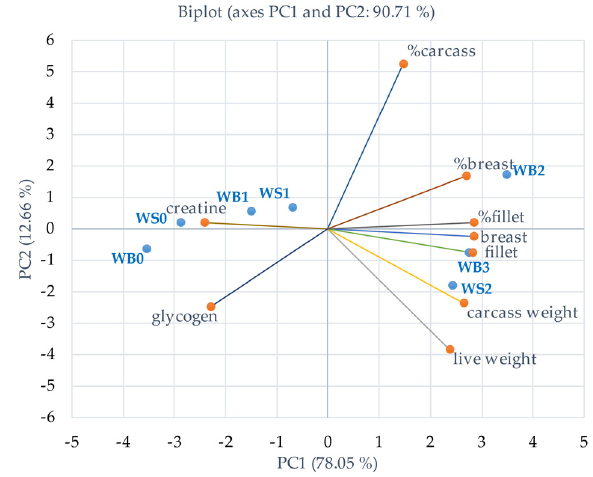
Figure 4. Principal component analysis biplot of wooden breast (WB) and white stripping (WS) severity score and carcass composition of broiler chickens at 42 days of age. WB; 0, 1, 2, 3 = wooden breast scores are based on a 4-point scale (3 = severe, 2 = moderate, 1 = mild, and 0 = normal); WS; 0, 1, 2, 3 = white striping scores are based on a 4-point scale (3 = severe, 2 = moderate, 1 = mild and 0 = normal).